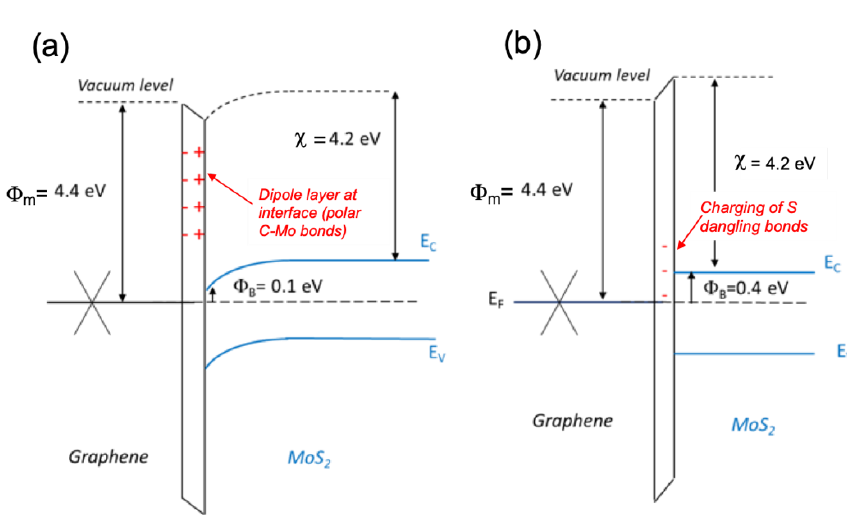
Figure 7. ( a ) Schematic energy band diagram of ( a ) Mo-terminated and ( b ) S-terminated zigzag edge graphene/MoS 2 interfaces.